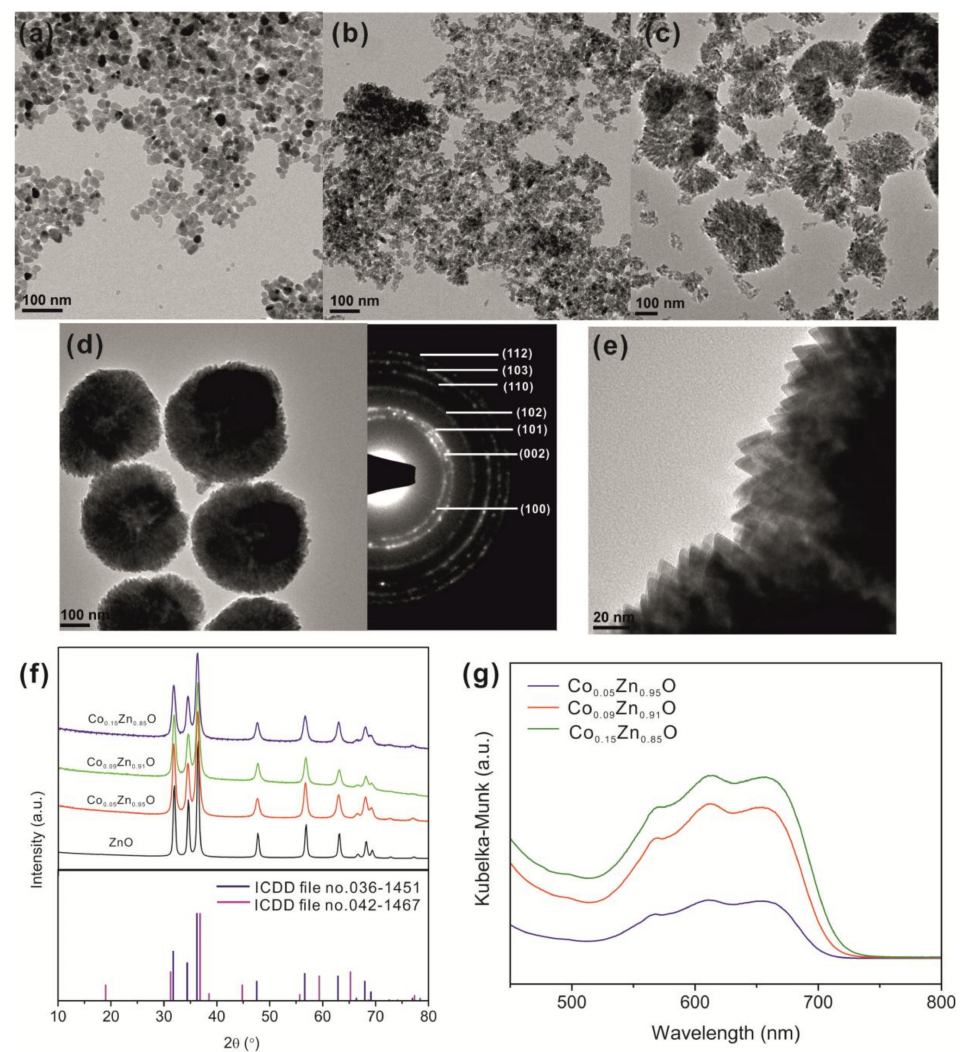
Figure 1. TEM images of ( a ) ZnO, Co-doped ZnO with ( b ) 5, ( c ) 9, and ( d , e ) 15 atom % of cobalt (as determined by EDX analysis); right part of ( d ) shows the selected area electron diffraction (SAED) pattern of Co 0.15 Zn 0.85 O nanostructures; ( f ) X-ray diffraction patterns of the ZnO and Co-doped ZnO materials (vertical lines correspond to reference patterns: blue-ZnO, pink-Co 3 O 4 ; ( g ) diffuse reflectance UV-vis spectra of the Co-doped ZnO